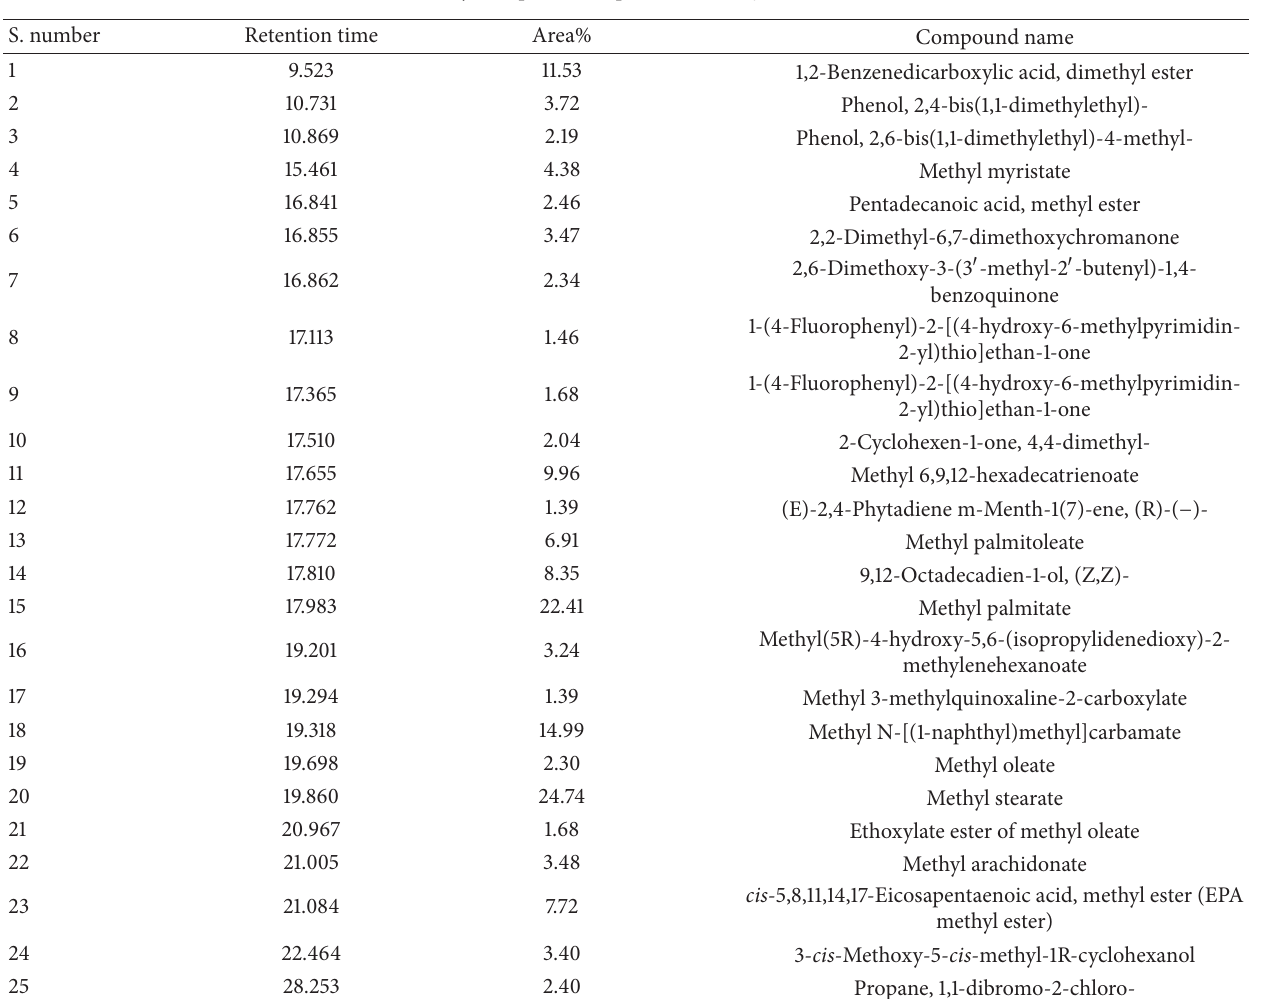
Table 3: Fatty acid profile of lipid from CHCl 3 :MeOH